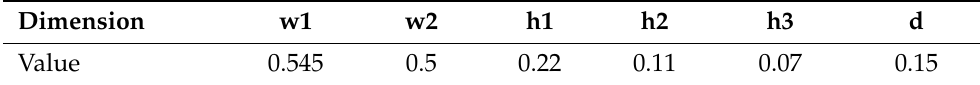
Table 1. List of geometric values in Figure